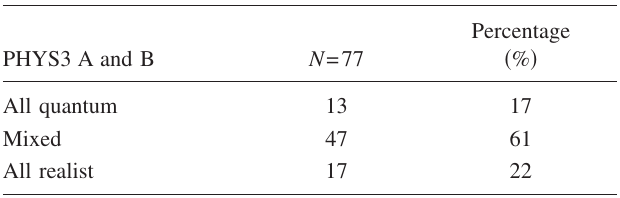
TABLE IX. Consistency of student responses from both PHYS3 courses to both essay questions and QA No.